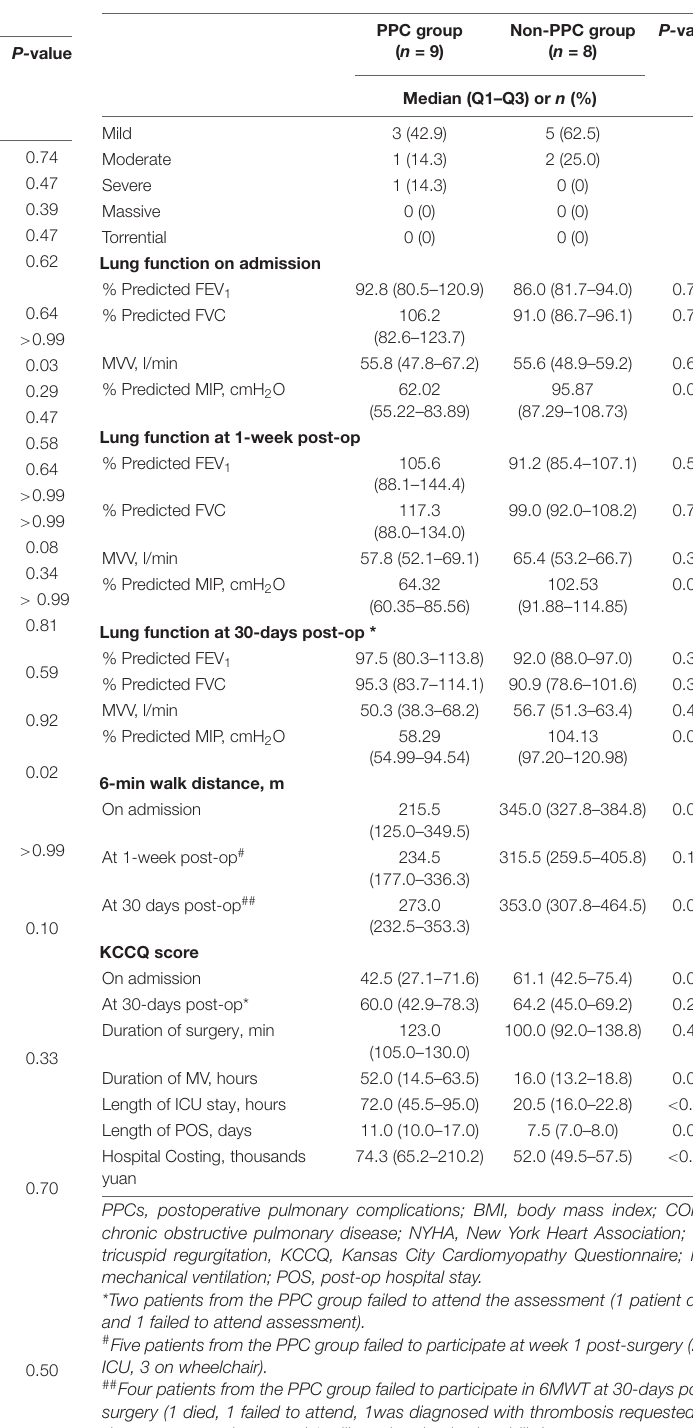
TABLE 4 | Outcome comparisons for patients with and without post-operative